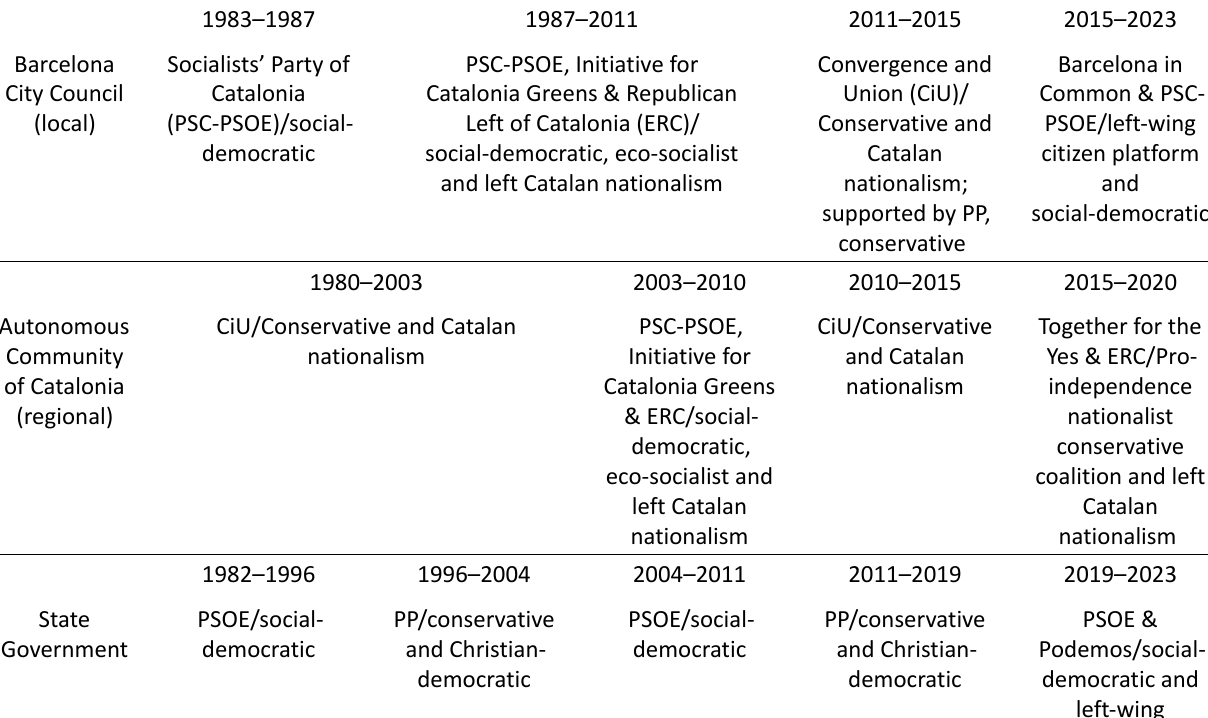
Table 2. Contextualisation of multilevel governance in Barcelona